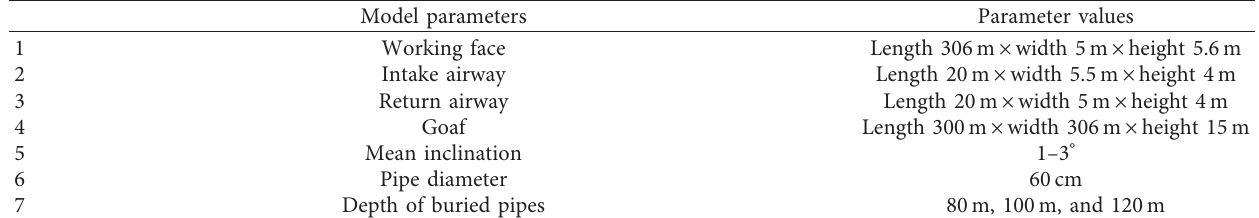
Table 3: Basic model parameters.